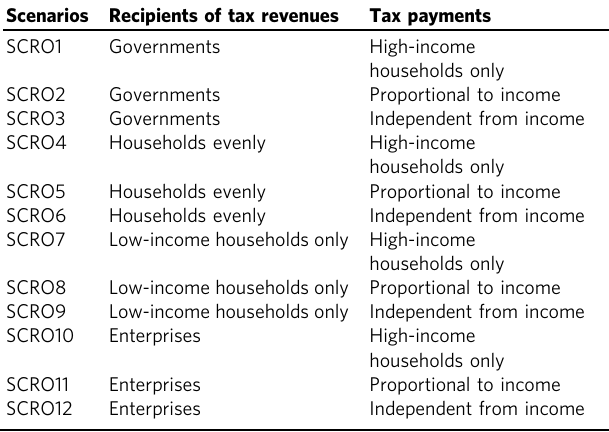
Table 3 The designed scenarios in this